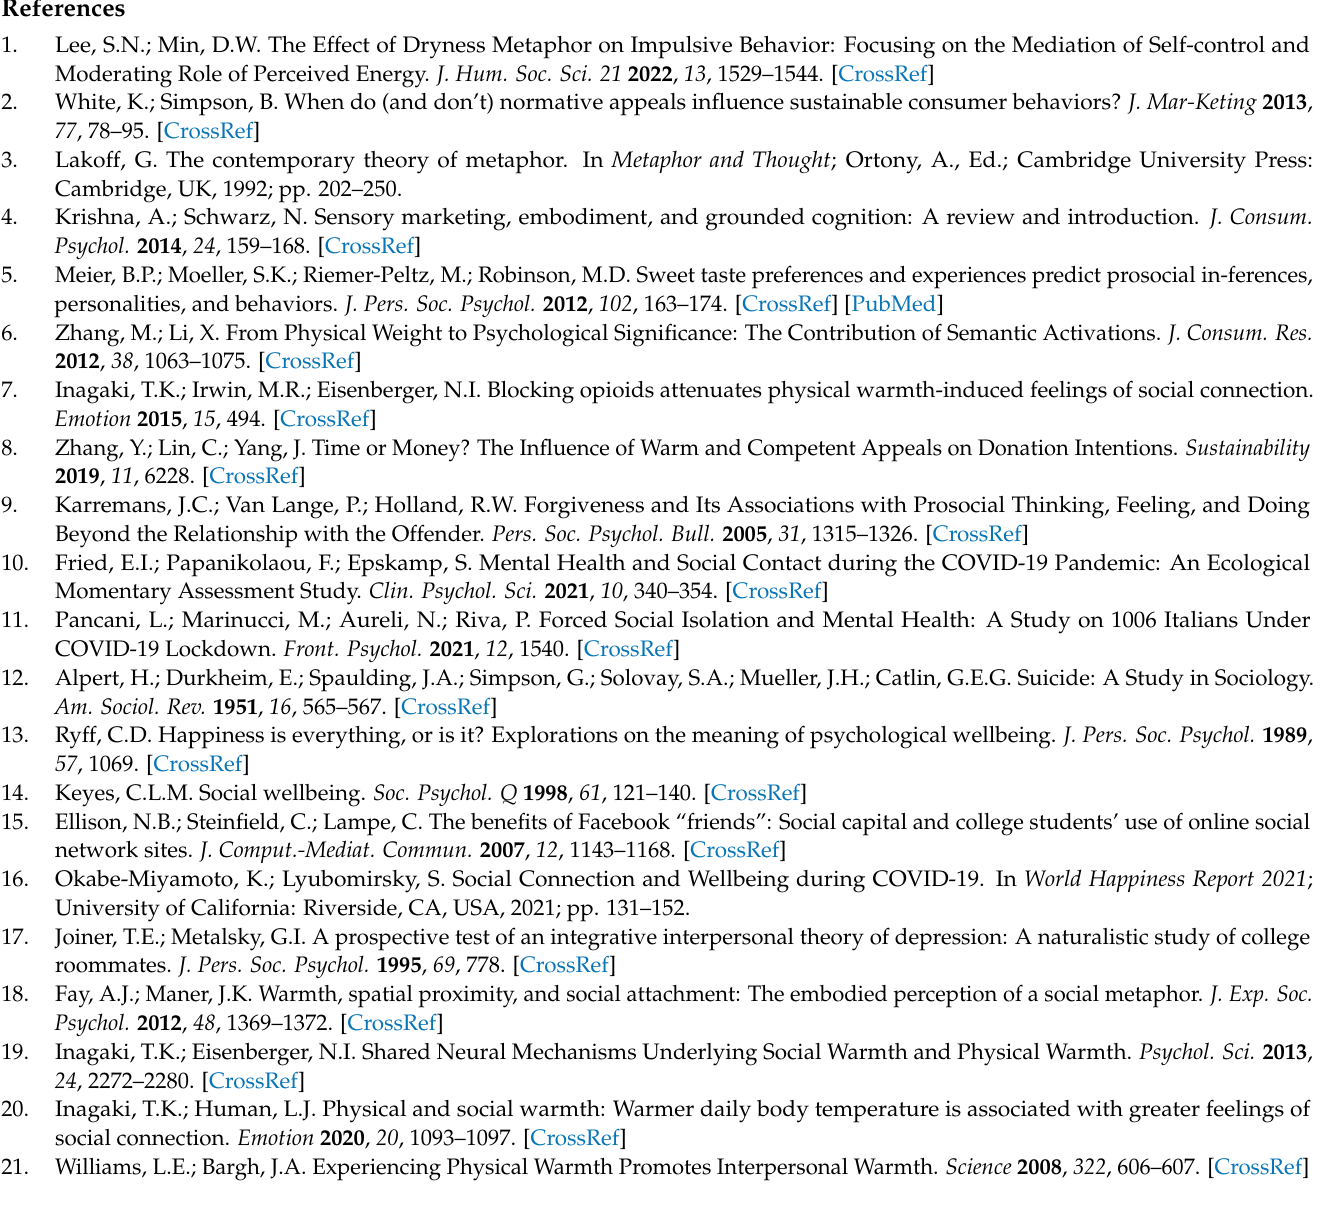
Figure A3. IOS: Inclusion of Other in the Self scale.